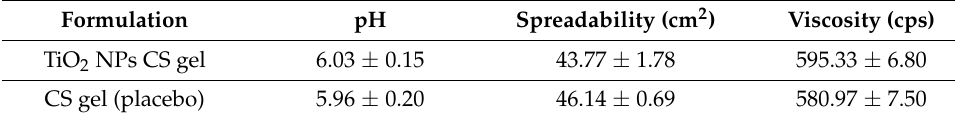
Table 1. Physical characterization of CS gel and CS gel containing TiO 2 NPs.